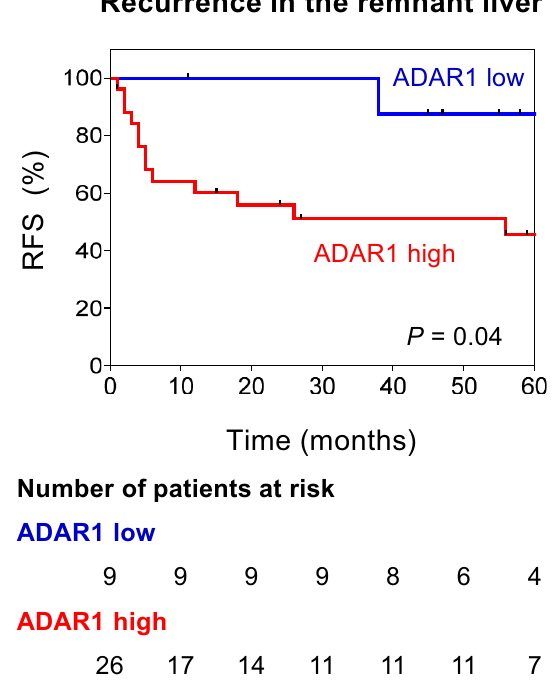
Figure 4. Association between ADAR1 expression and remnant liver recurrence. Patients with liver metastases who have high ADAR1 levels had earlier remnant liver recurrence.